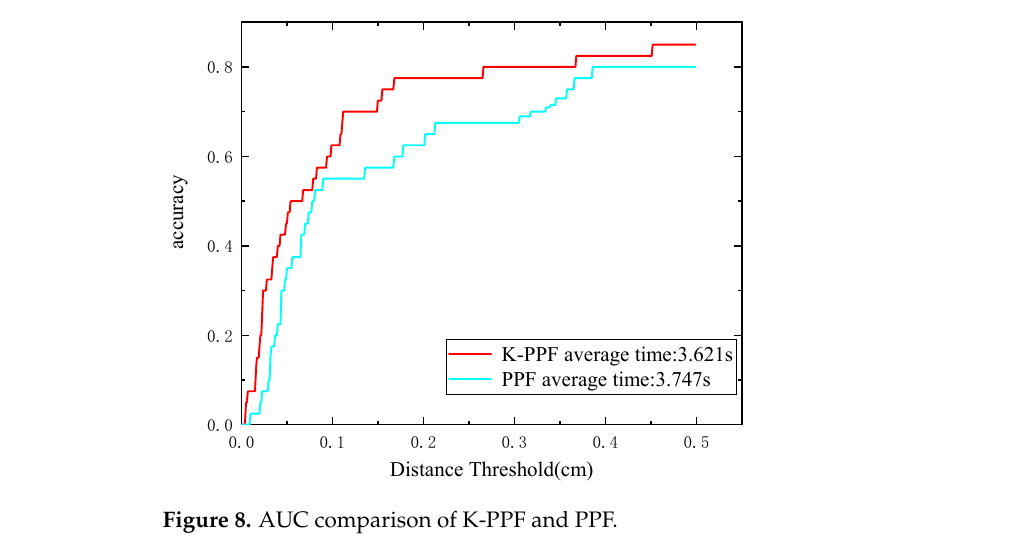
Figure 7. Distance threshold–accuracy curve.